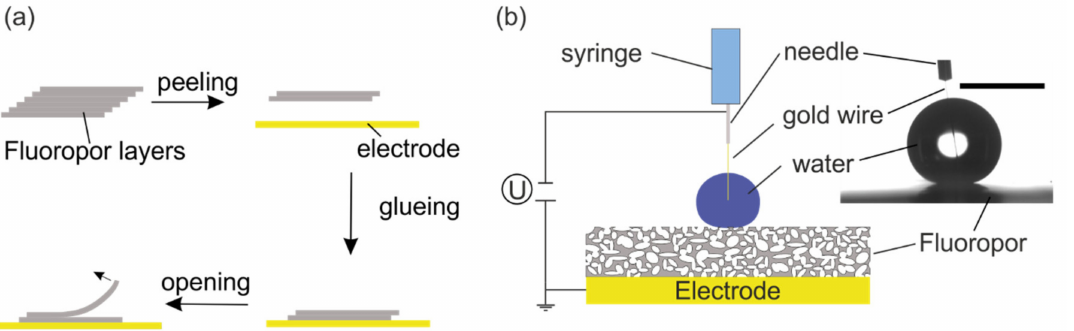
Figure 1. Fabrication process and measurement setup for the wetting behavior experiments: ( a ) Fab- rication process of Fluoropor surfaces for wetting behavior experiments: From the 3D-printed stack of individual Fluoropor (grey) layers, a double layer (fabricated according to our previous work [56]) was peeled off and glued on a steel panel, which functioned as an electrode (yellow). After the adhesive cured, the protective top layer of the Fluoropor double layer was removed to open the target surface for the wetting experiment. ( b ) The setup of the wetting transition experiment consisted of the steel electrode, which was connected to the mass of the power supply, the porous Fluoropor coating on top of it and the water dispersing unit with the metal needle connected to the phase of the power supply. A thin gold wire inside the syringe facilitated electrical connection to the water droplet. Right: Actual image from the CA goniometer showing the droplet, which was connected over the thin gold wire to the syringe. Scale bar: 2